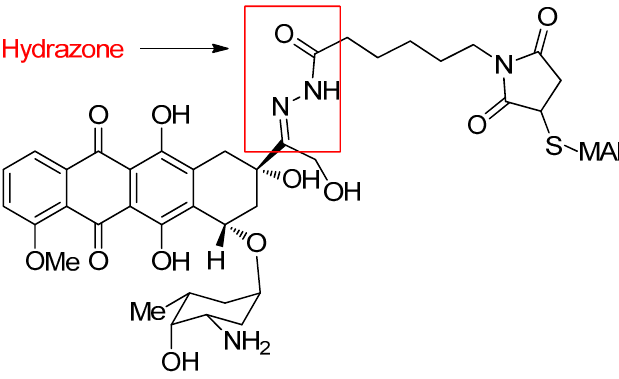
Figure 7. The structural formula of BR96-doxorubicin. Adapted from reference [52].